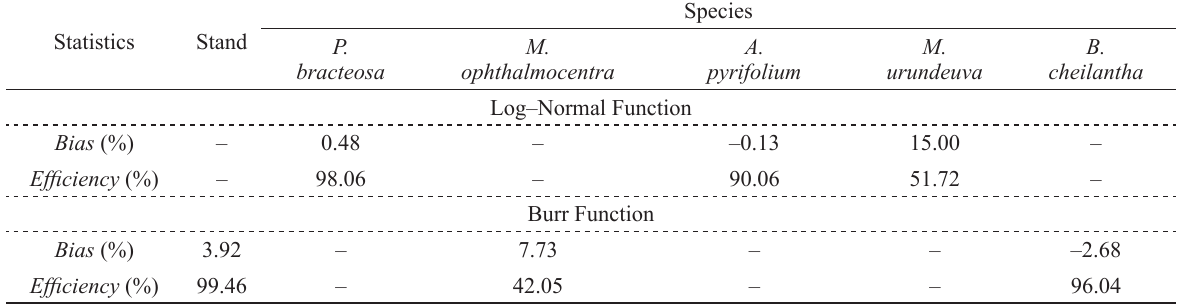
validation of the functions selected through the AIC value for the stand and for HIV